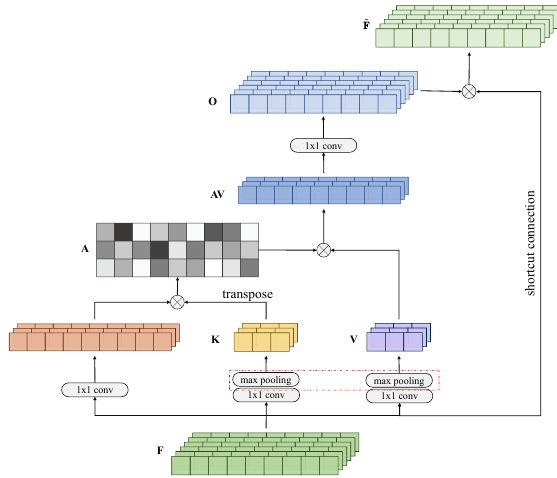
Figure 1. Illustration of the stand-alone self-attention layer with L = 9, C = 6, p = 3, and b = 2. The max pooling layers in the red frame are discarded for matrix K and V when modeling locality of the stand-alone self-attention